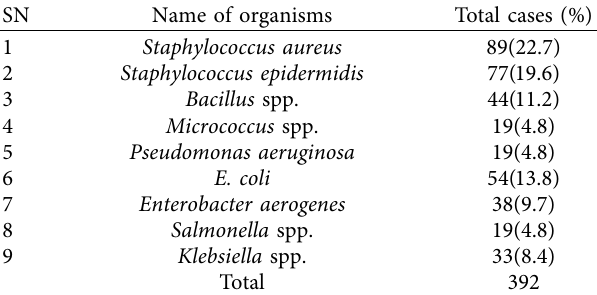
Table 1: Growth pattern of bacteria.